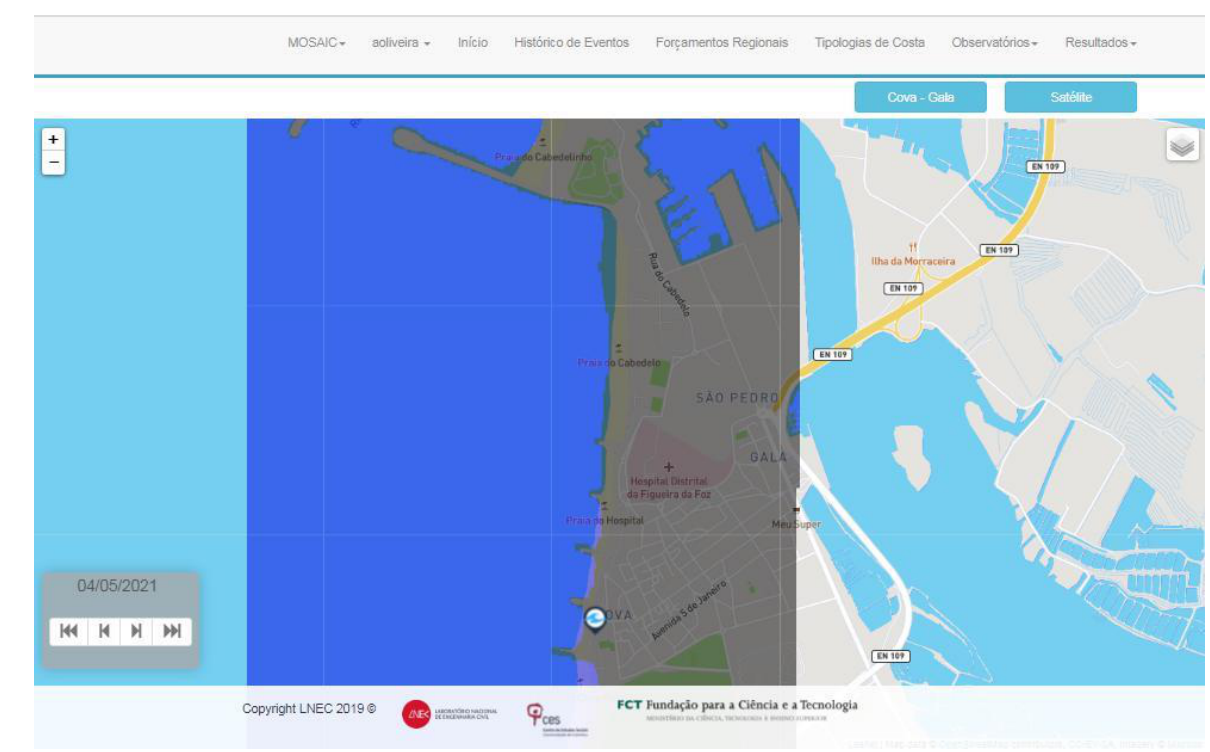
Figure 11. Sample land/water interface at the Cova-Gala observatory represented by dark ( land ) and blue ( water ) pixels.